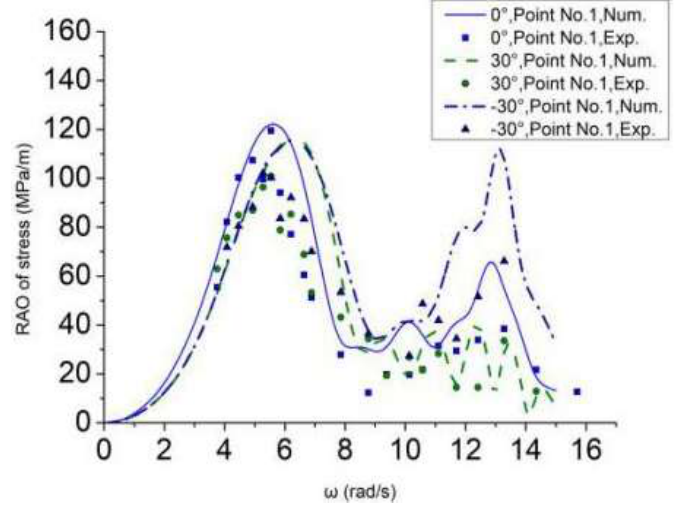
Figure 7. Frequency results of point 1 with wave direction 0°, 30° and −30°.